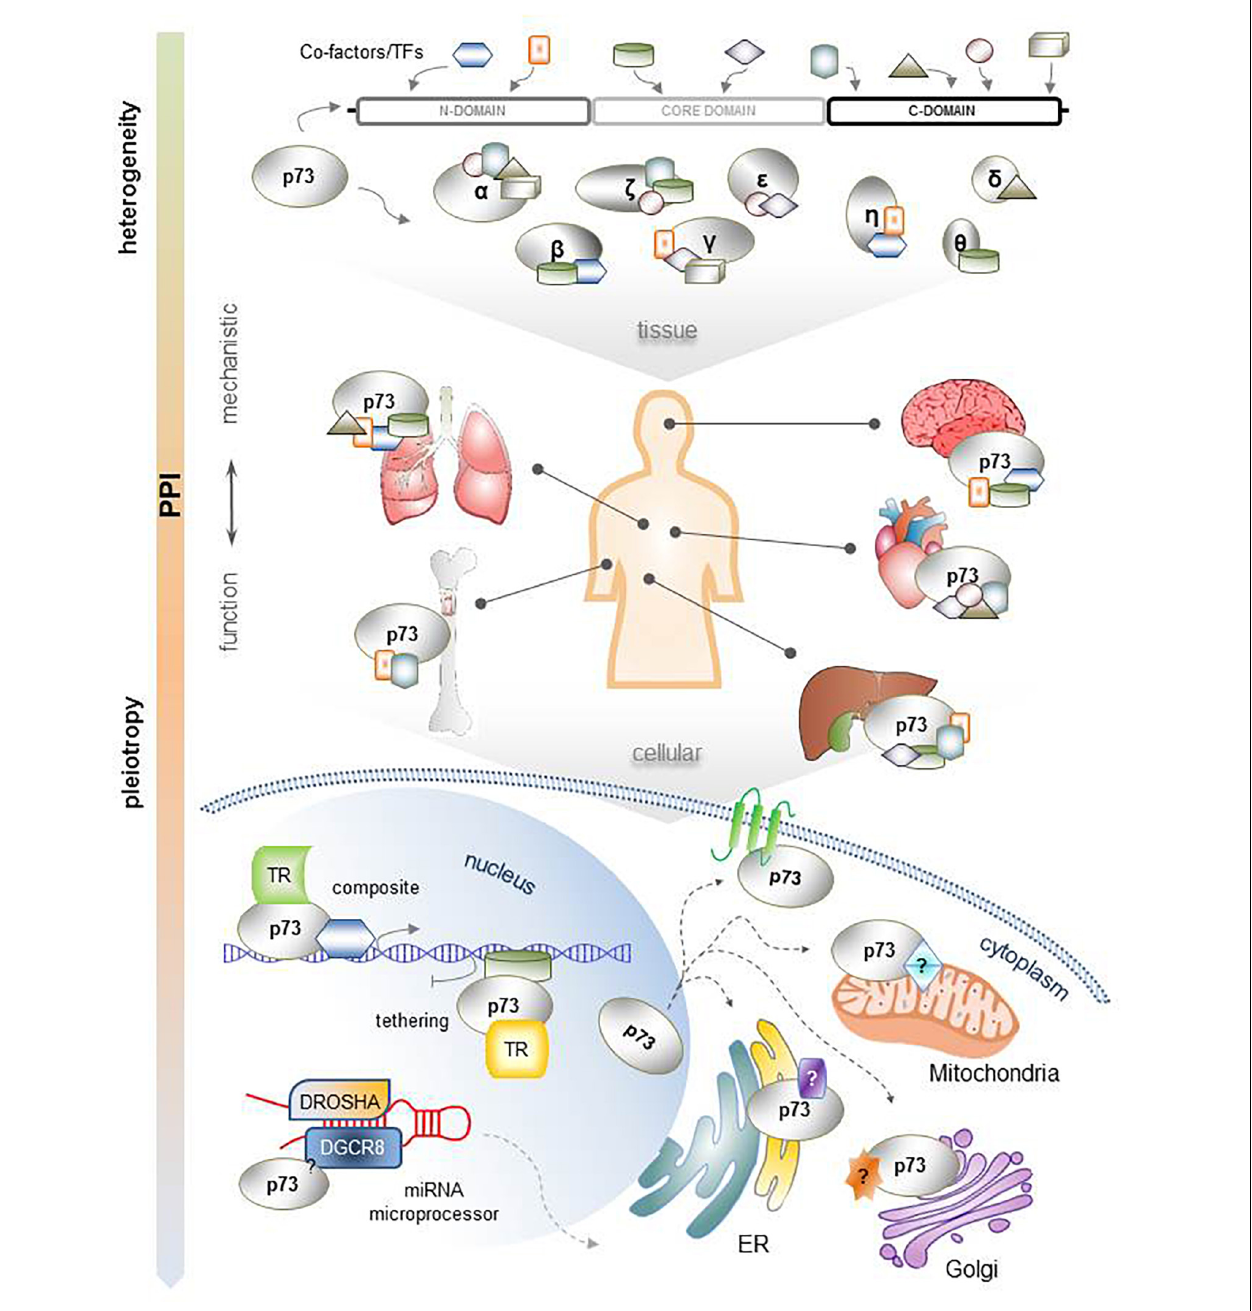
FIGURE 4 | Comprehensive illustration of the mechanistic heterogeneity that supports the functional pleiotropy of TP73. Each p73 isoform has a unique combination of interacting motifs and residues that can develop distinct PPIs. This is particularly important for their function across several organ systems, which present tissue-specific protein contents. The resulting complexes of p73 isoforms with their protein binding partners interact with gene promoters according to composite or tethering mechanisms of gene transcription regulation; are integrated in other multi-protein complexes within the nucleus, such as the miRNA processing complex, to control miRNA maturation; or are localized in the cytoplasm, possibly affecting the function of several subcellular organelles and/or the plasma membrane.